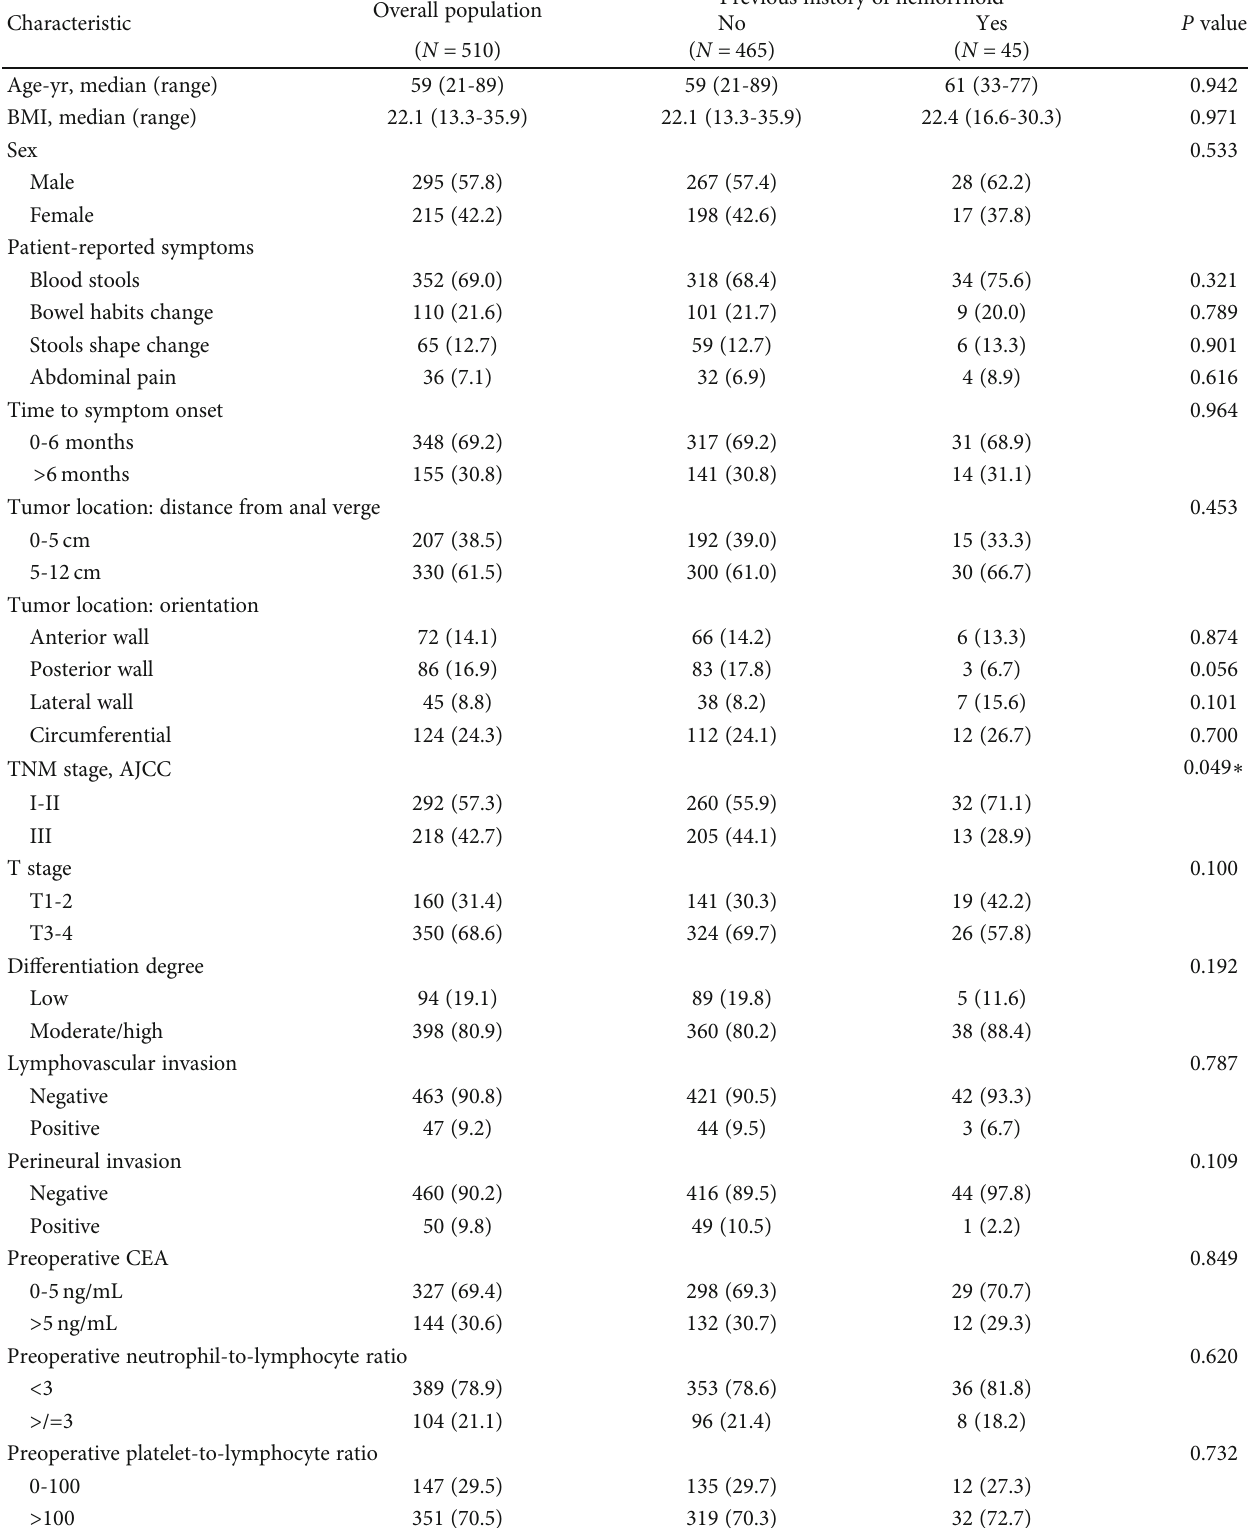
Table 1: Distribution of baseline characteristics between patients with and without previous history of